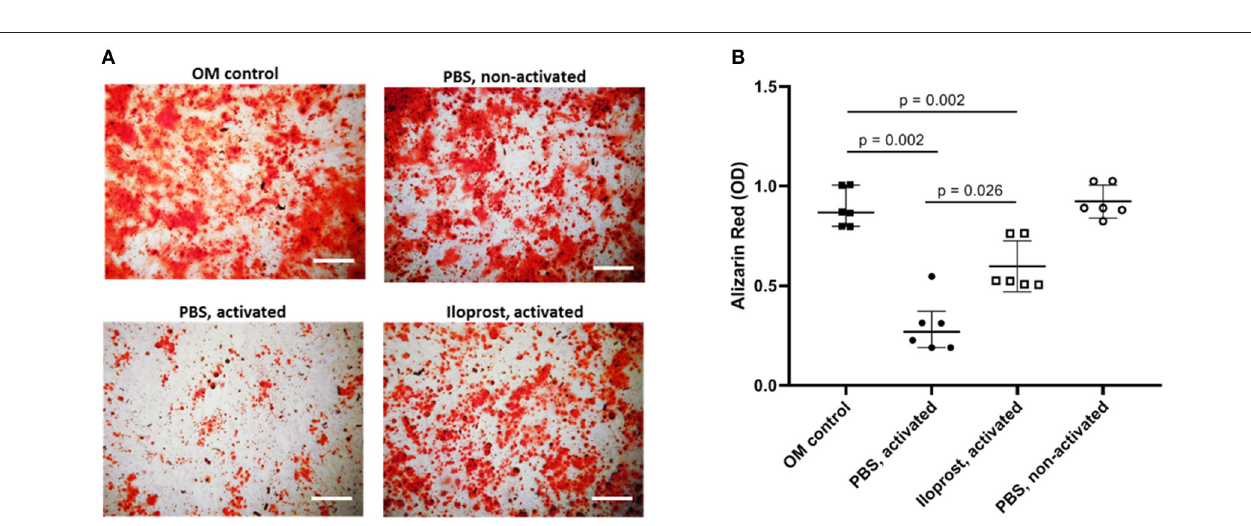
FIGURE 8 | Osteoimmunological effect of Iloprost treated isolated CD8 + T cells. Isolated α -CD3/ α -CD28 activate CD8 + T cells were cultured either with Iloprost or PBS as control. Obtained conditioned media was added to an osteogenic differentiation culture of MSCs and the secretion of mineralized matrix was measured by Alizarin Red staining. (A) Representative images of the Alizarin Red staining of the different culture conditions. (B) Quantification of the Alizarin Red signal. OM, osteoinductive media. Scale bars: 200 µ m; n = 6.